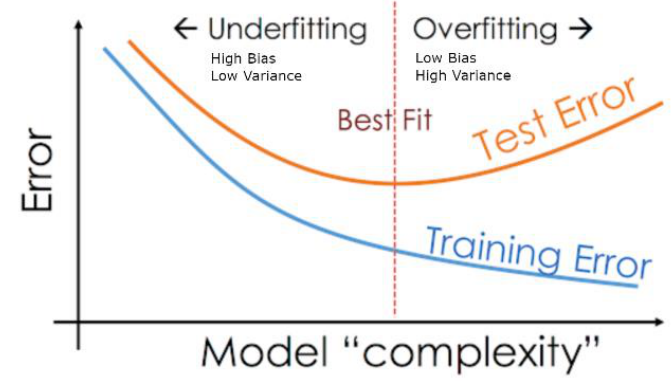
Figure 9. Underfitting, overfitting, and best fit example.